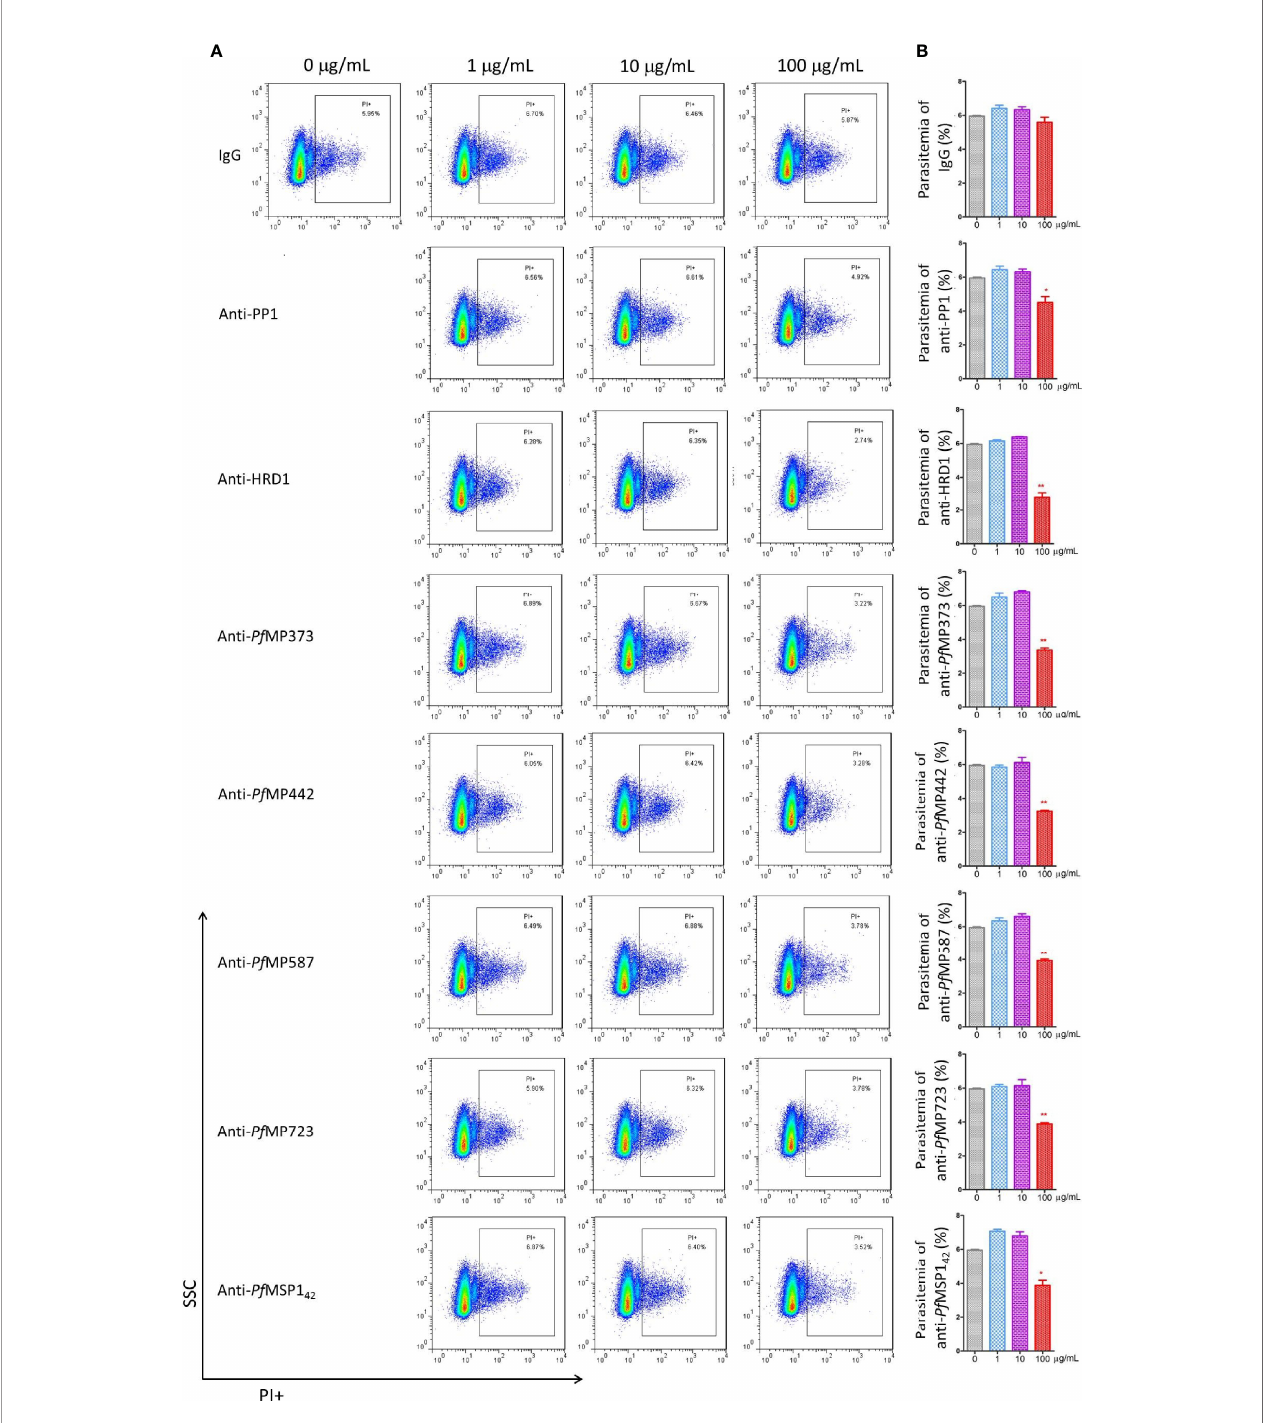
FIGURE 5 | Merozoite protein-speci fi c antibodies inhibit parasite proliferation. Highly synchronized schizont-stage parasites of P. falciparum 3D7 strain were cultured in the presence of total IgG containing polyclonal antibodies (Ab) against merozoite proteins and IgG control derived from naïve rabbits. Parasitemia was determined using fl ow cytometry after 40 – 42 h of culture. (A) Representative dot plots showing the frequency of propidium iodide positive infected red blood cells (iRBCs). (B) Histograms comparing parasitemia between the antibody-treated group and the IgG control group using Mann-Whitney test. These results are representative of three independent experiments, with data indicating mean ± standard deviation. * p < 0.05 and ** p < 0.001. *Indicates comparison with the corresponding naïve IgG group. PP1, serine/threonine protein phosphatase 1; HRD1, endoplasmic reticulum-associated degradation (ERAD)-associated E3 ubiquitin-protein ligase 1; Pf MP, Plasmodium falciparum merozoite protein; MSP-1 42 , merozoite surface protein-1 42 kDa